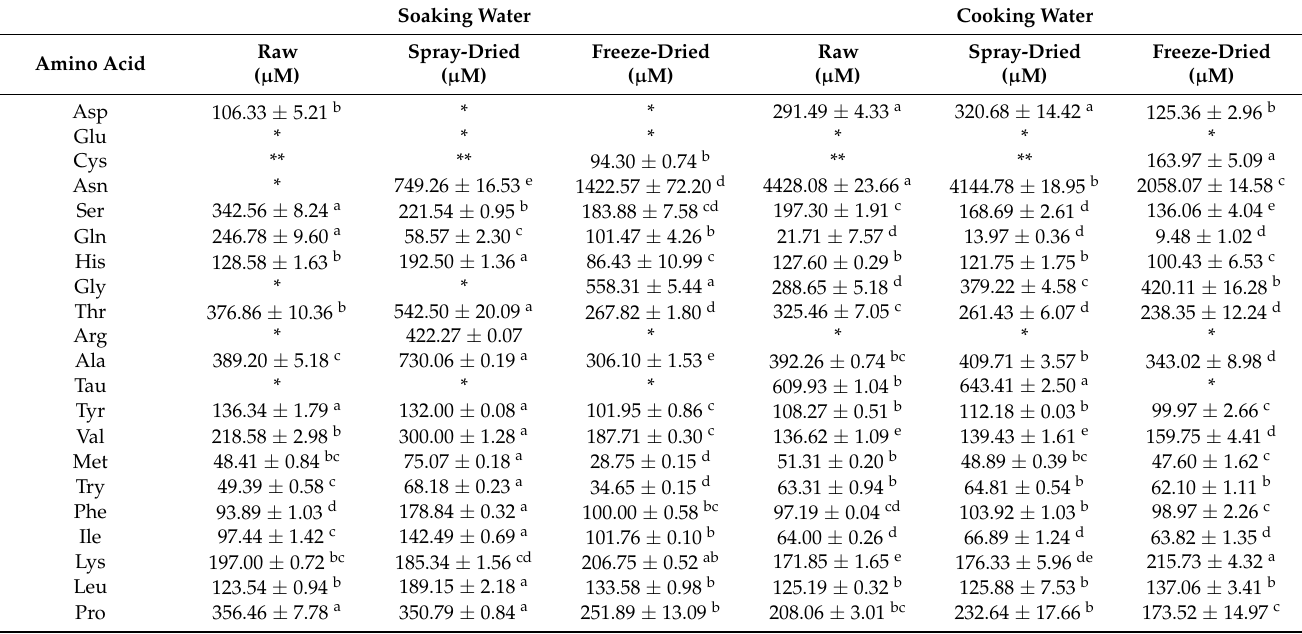
Table 2. Free amino acid profiles of different pea soaking and cooking water. Different letters represent statistical difference ( p <